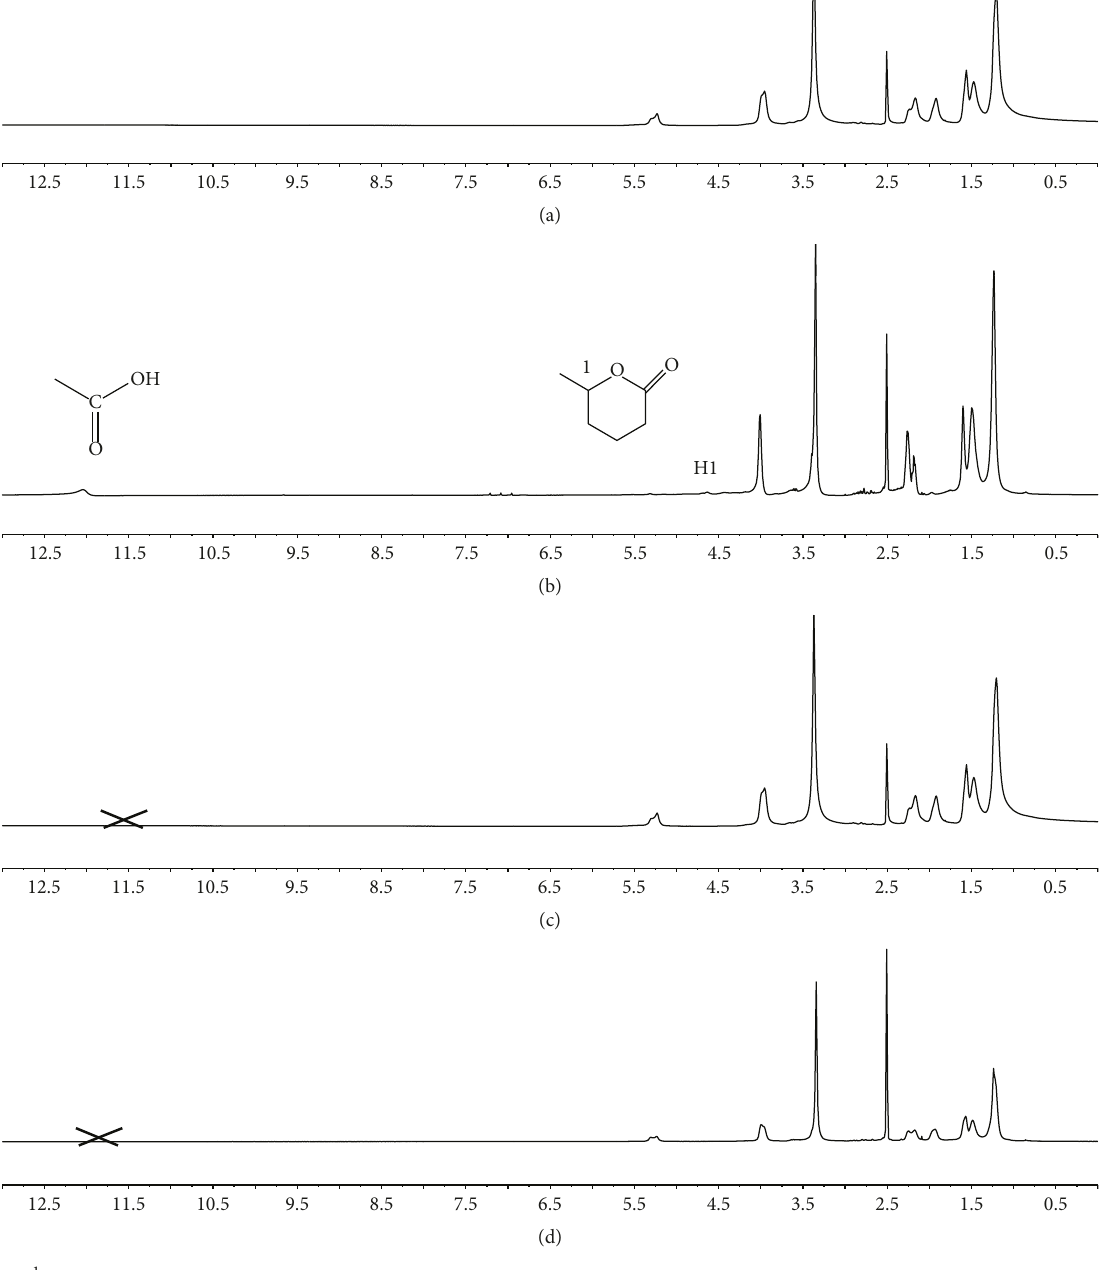
Ss (400MHz, DMSO-d6): (a) initial sample; (b) degraded sample in water 80 20